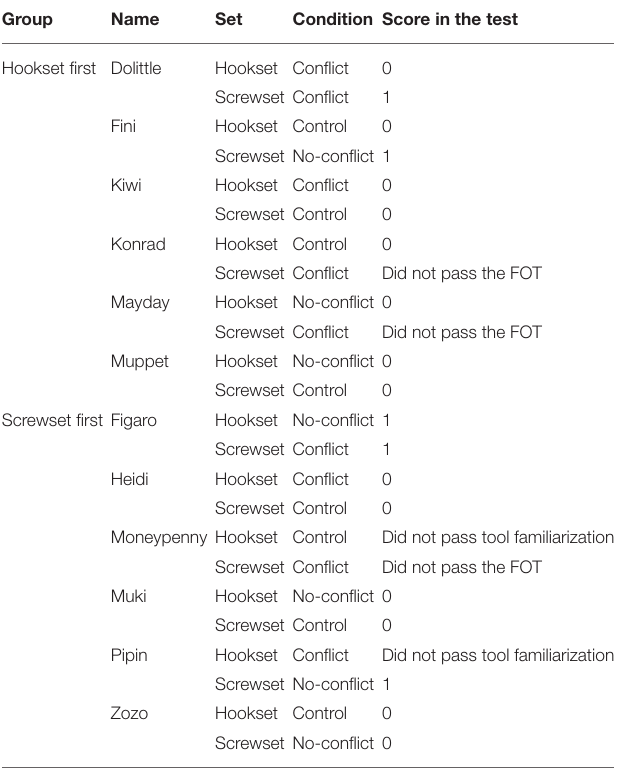
TABLE 1 | An overview of the experimental